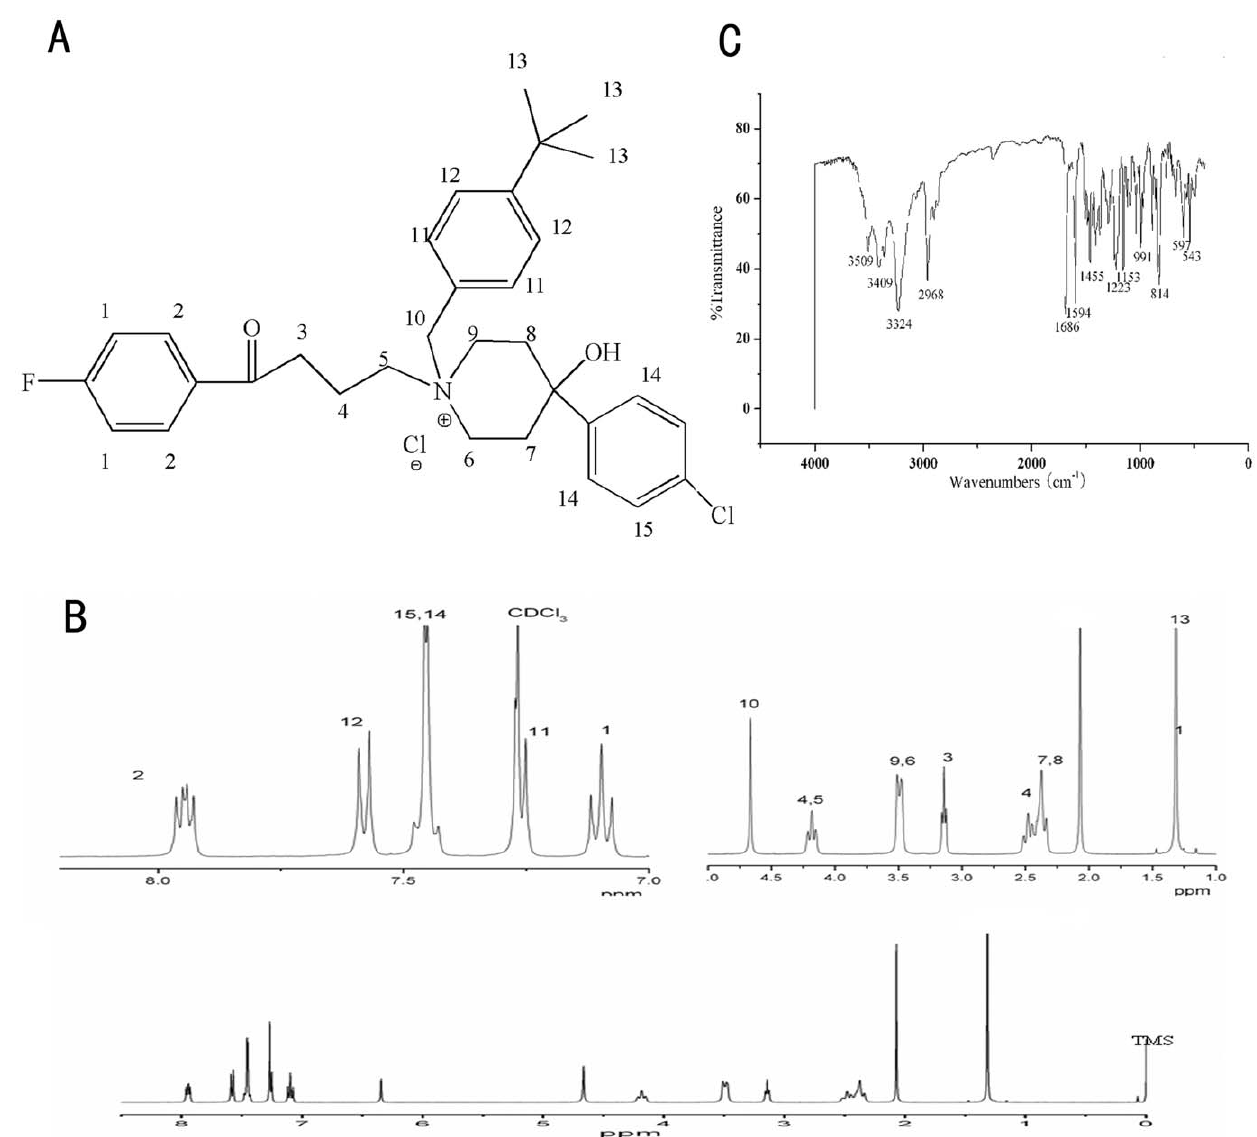
Figure 2. The chemical structure of 16c (A); 400 MHz 1 H NMR spectrum of 16c in CDCl 3 (B); Infrared Spectroscopy of 16c (C).